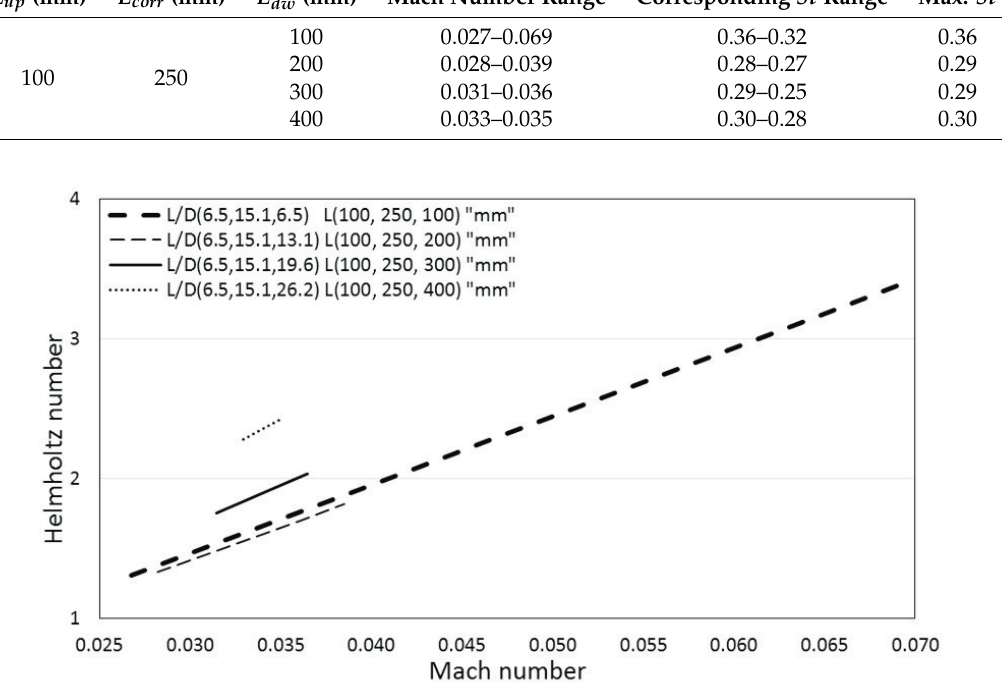
Figure 7. Helmholtz number He plotted against Mach number M for L up = 100 mm, L corr = 250 mm, and L dw = 100–400